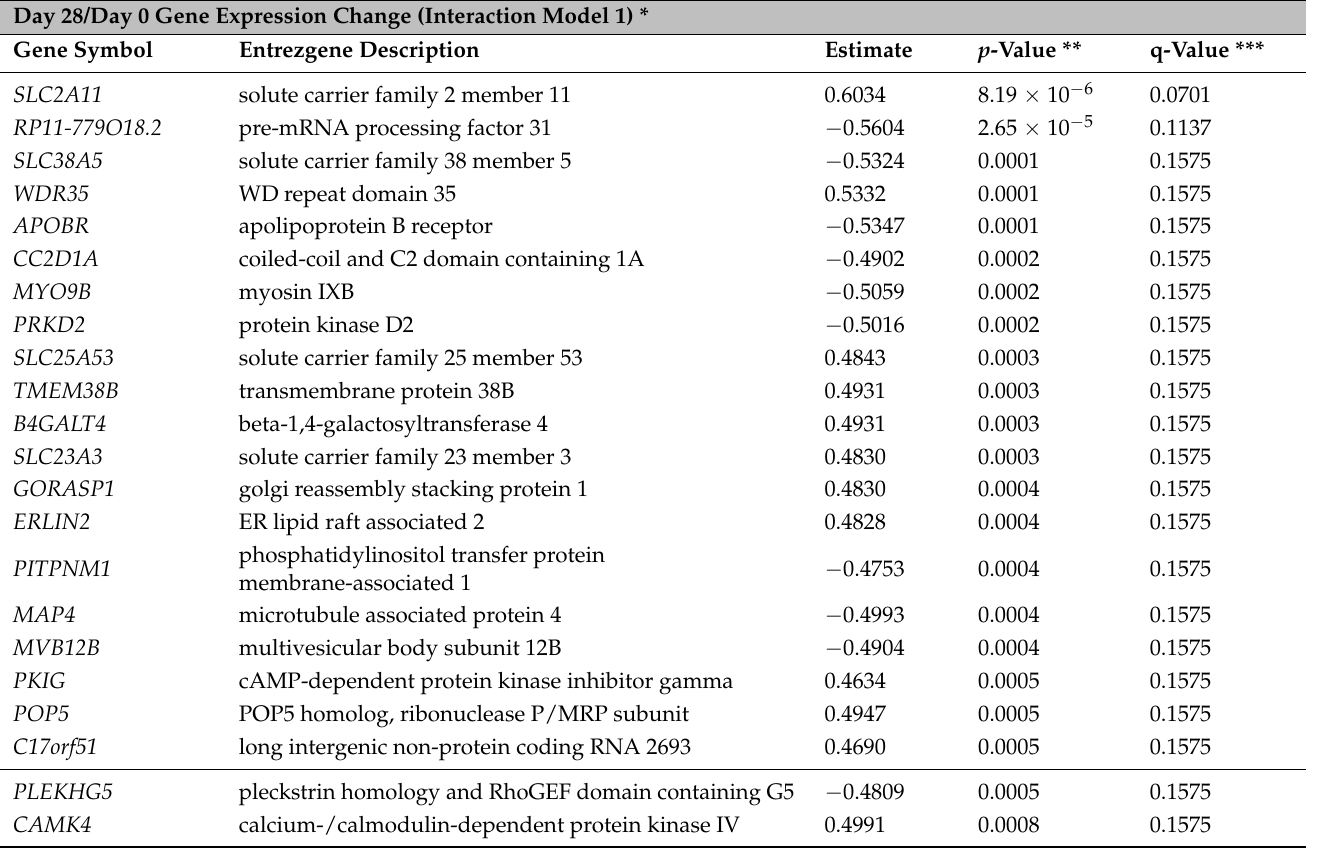
Table 2. Influence of vaccine type and CD4 + T cell gene expression change on Ab response to influenza vaccination (Day 28-Day 0 HAI titer change). Full list of genes is expanded in Supplementary Table